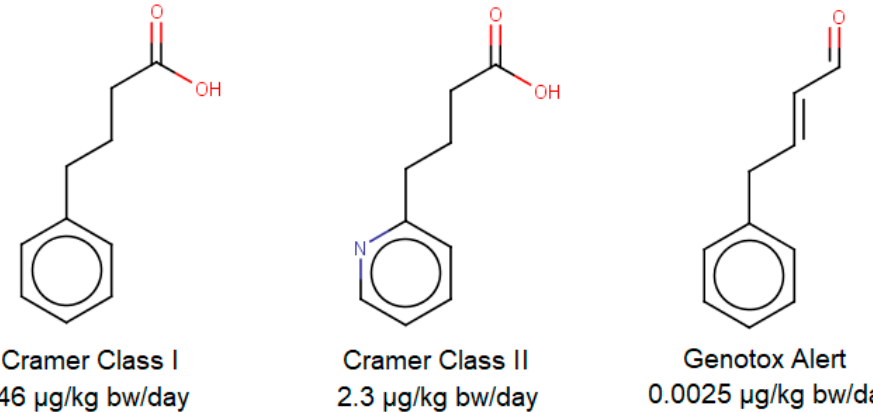
Figure 1. Three structurally similar compounds investigated via ToxTree v3.1.0. From left to right: 4-phenylbutyric acid (CAS 1821-12-1), 4-(2-pyridinyl) butanoic acid (CAS 102879-51-6) and 4-phenylcrotonaldehyde (CAS 13910-23-1).